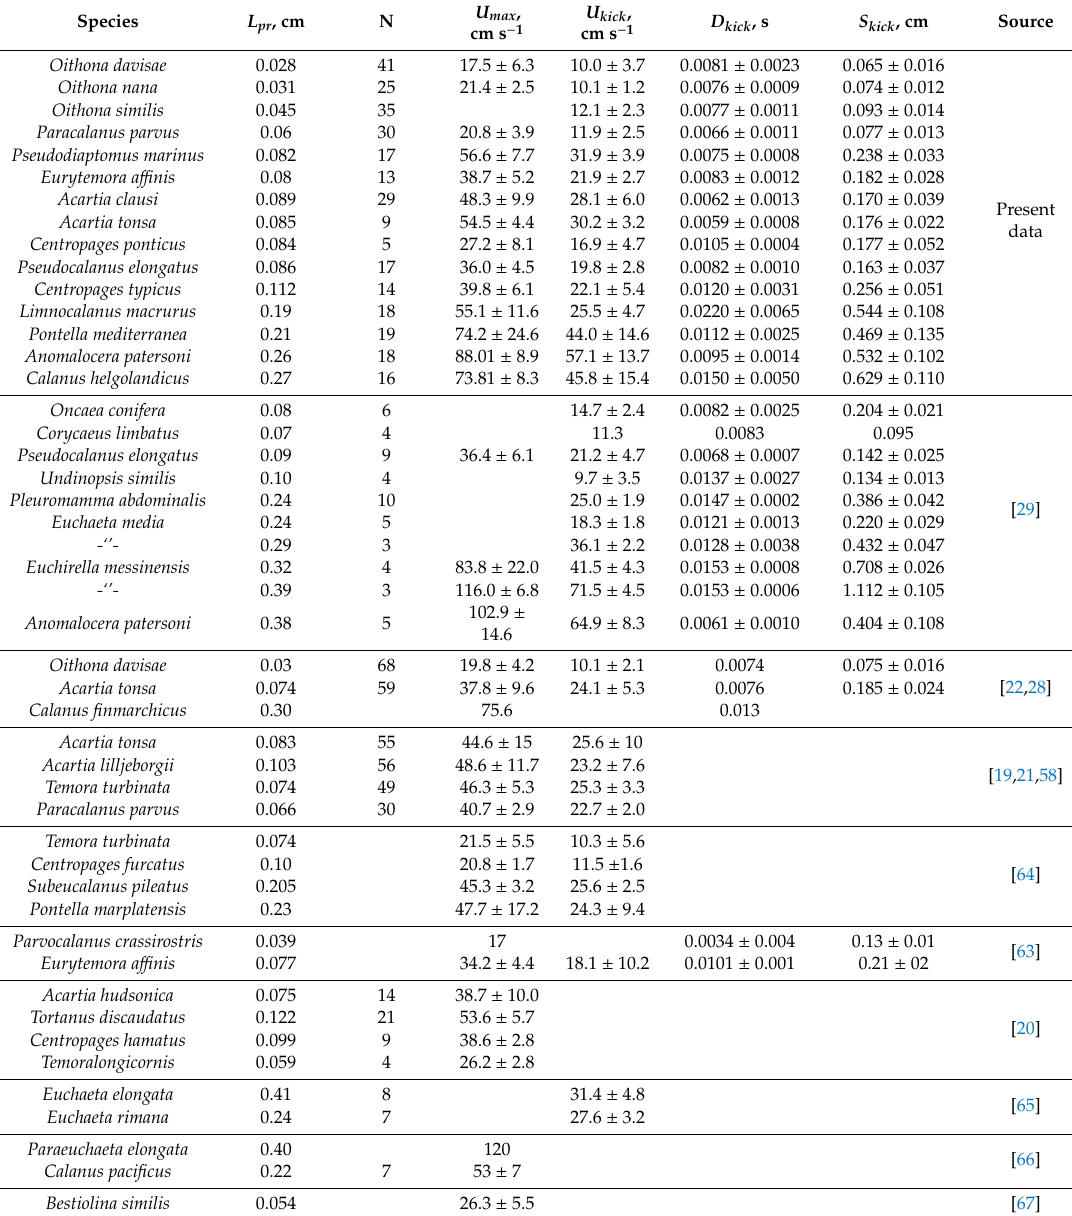
Table 3. Kinematic parameters of the escape reaction in calanoid and cyclopoid copepods at 20–22 ◦ C. L pr : prosome length, cm; U max : maximum instantaneous speed, cm s − 1 ; U kick : mean speed of